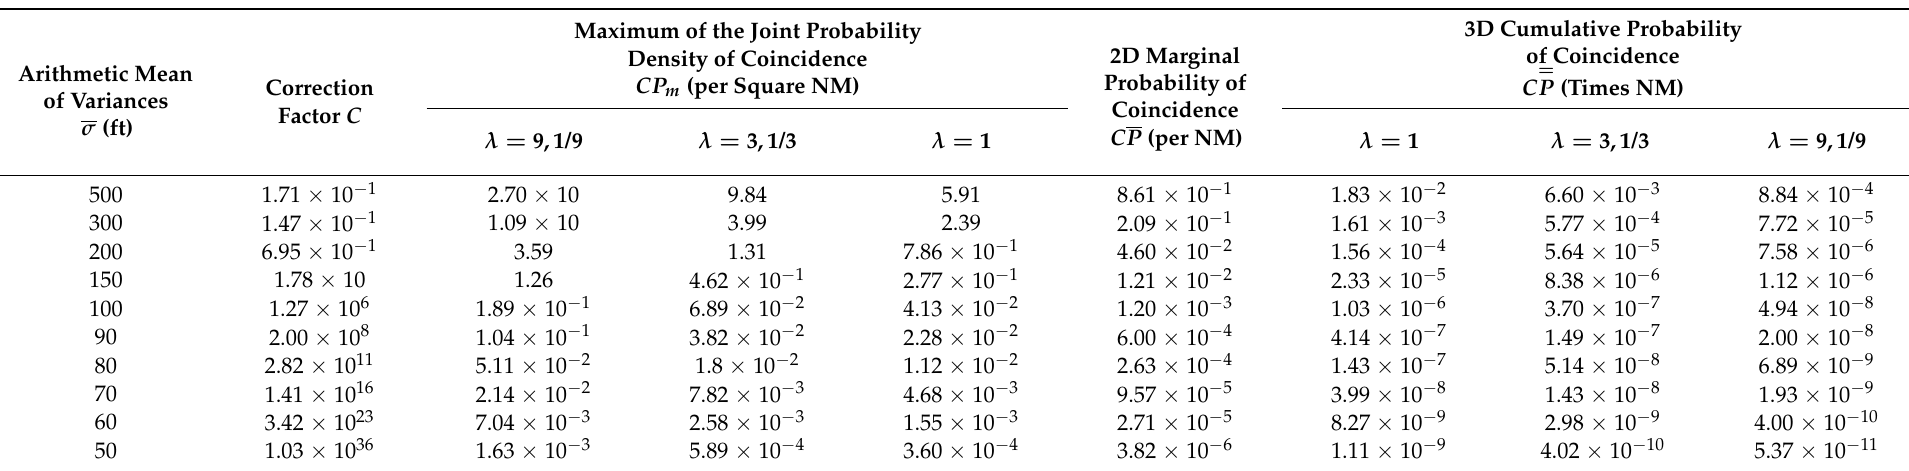
Table 6. As in Table 2 for a reduced vertical separation L = 1000 ft (as in Table 3) with correction factor of the generalized error probability distribution relative to the Gaussian (as in Table